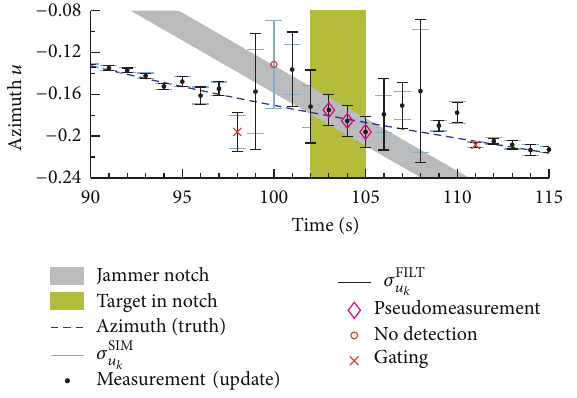
Figure 20: Exemplary azimuth measurements and models for a specific time window for tracking scenario of Figure